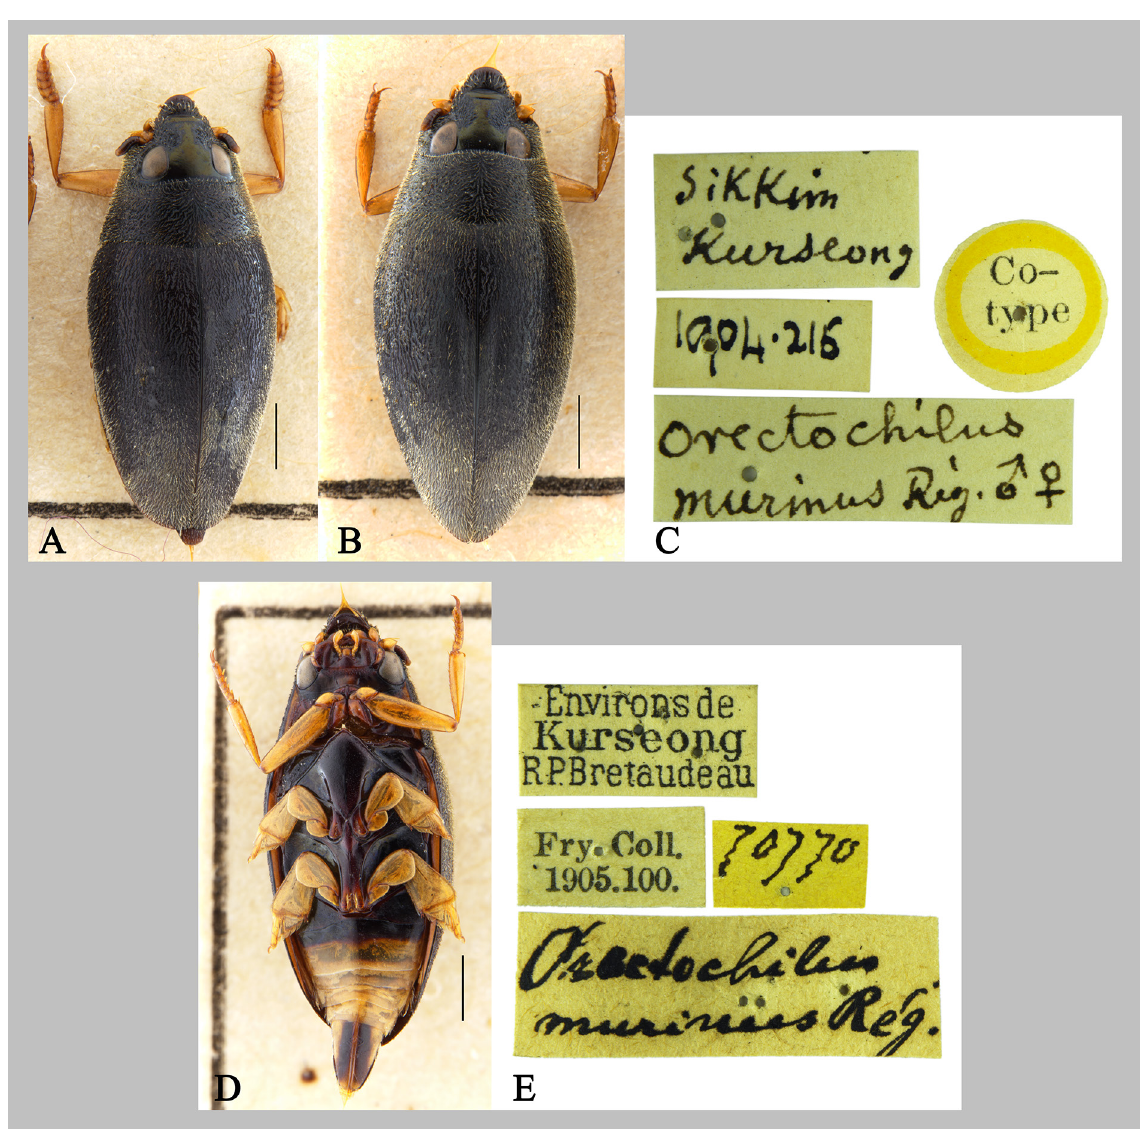
Fig. 10. Orectochilus murinus Régimbart, 1892 (BMNH). A–C . Co-type. D–E . Additional material. A . ♂, habitus, dorsal view. B . ♀, habitus, dorsal view. C . Label. D . ♀, habitus, ventral view. E . Label. Scale bar = 1